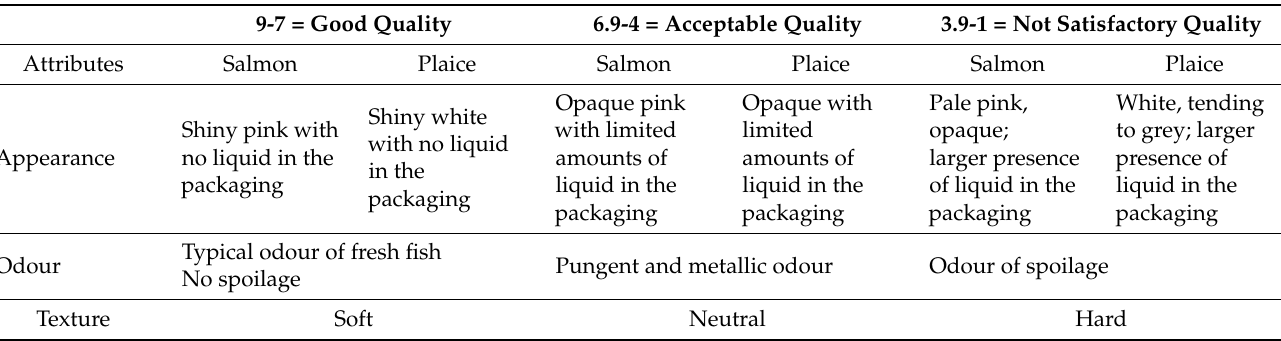
Table 1. Sensory processing